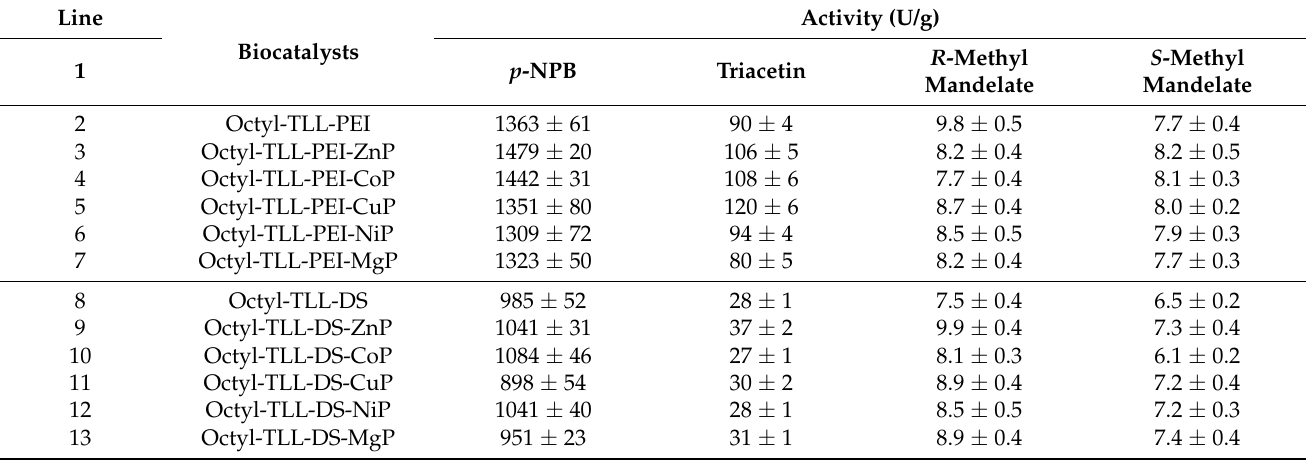
Table 4. Specific activity of different immobilized and physically modified biocatalysts after solid- phase mineralization. The hydrolytic activity was measured using 1 mM p -NPB (pH 7 and 25 ◦ C), 50 mM triacetin (pH 7 and 25 ◦ C), and 50 mM R - or S -methyl mandelate (pH 7 and 25 ◦ C). Experiments were conducted as described in